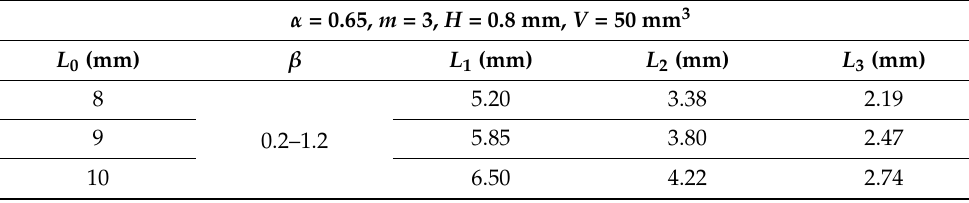
Table 3. Geometric parameters of branched HCM with different L 0 .